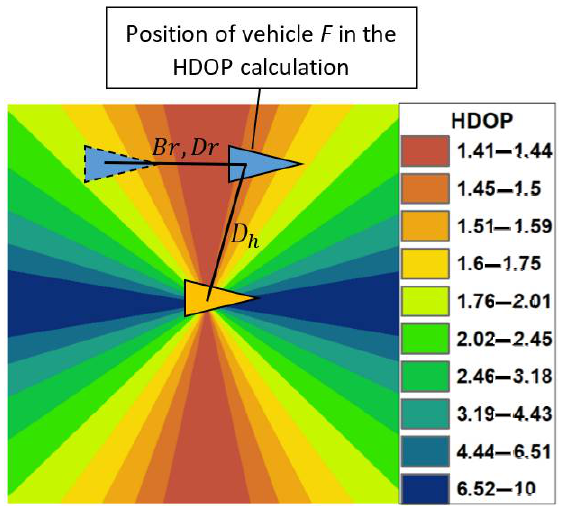
Figure 2. Distribution of the HDOP coefficient in the swarm leader–single vehicle relation (a proprietary app has been prepared with the use of the inverse distance weighting interpolation method).